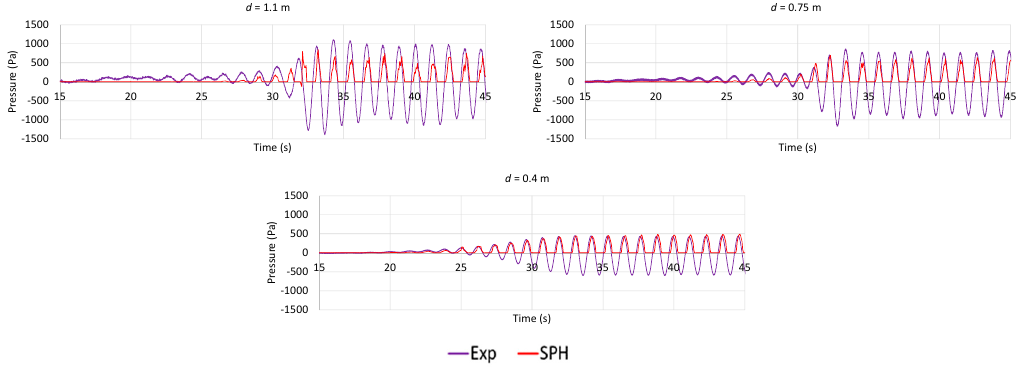
Figure 17. Dynamic wave pressure for A = 50.5 mm and T = 1.15 s.